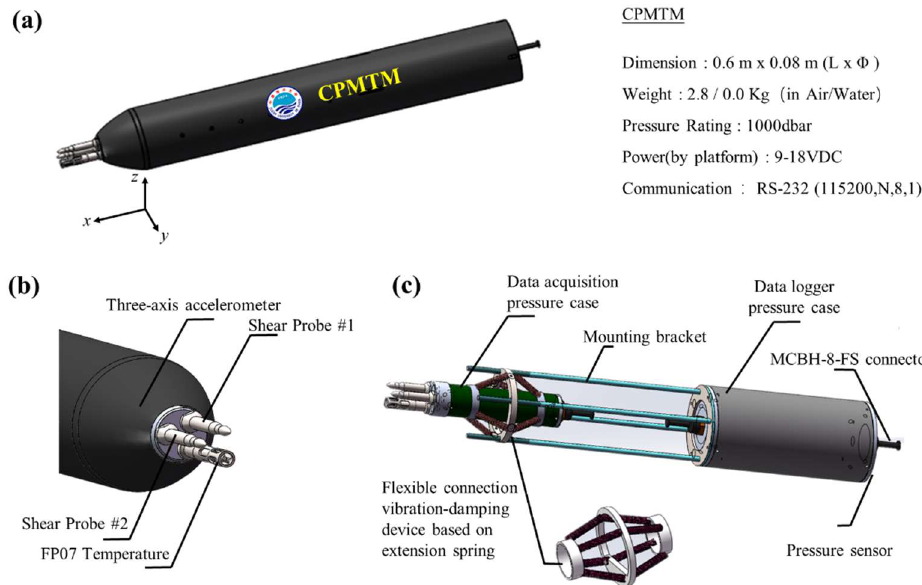
Figure 1. Design of the CPMTM: ( a ) schematic overview of the CPMTM; ( b ) array of turbulence sensors in the nose; ( c ) CPMTM with flexible connection vibration-damping device and other inter- nal structures.